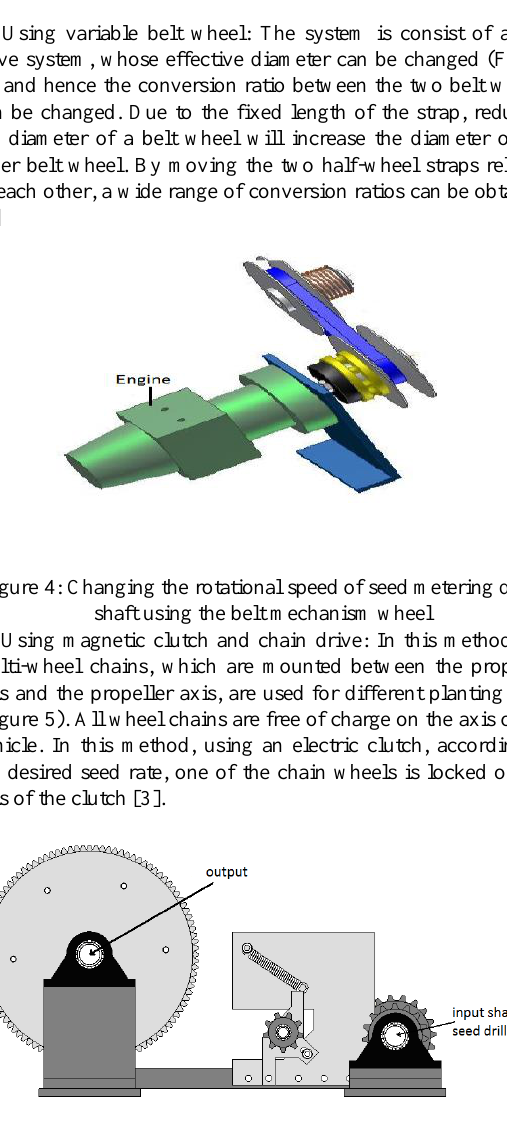
Figure 5: Changing the rotational speed of seed metering drive shaft using the magnetic clutch and a chain